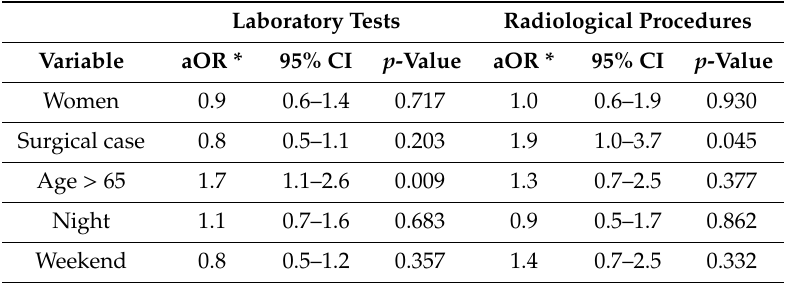
Table 2. Independent factors for redundant tests (laboratory and